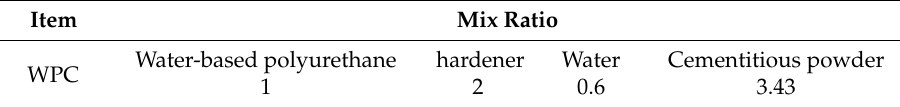
Table 6. Water-based polyurethane finisher with cementitious powder (WPC).